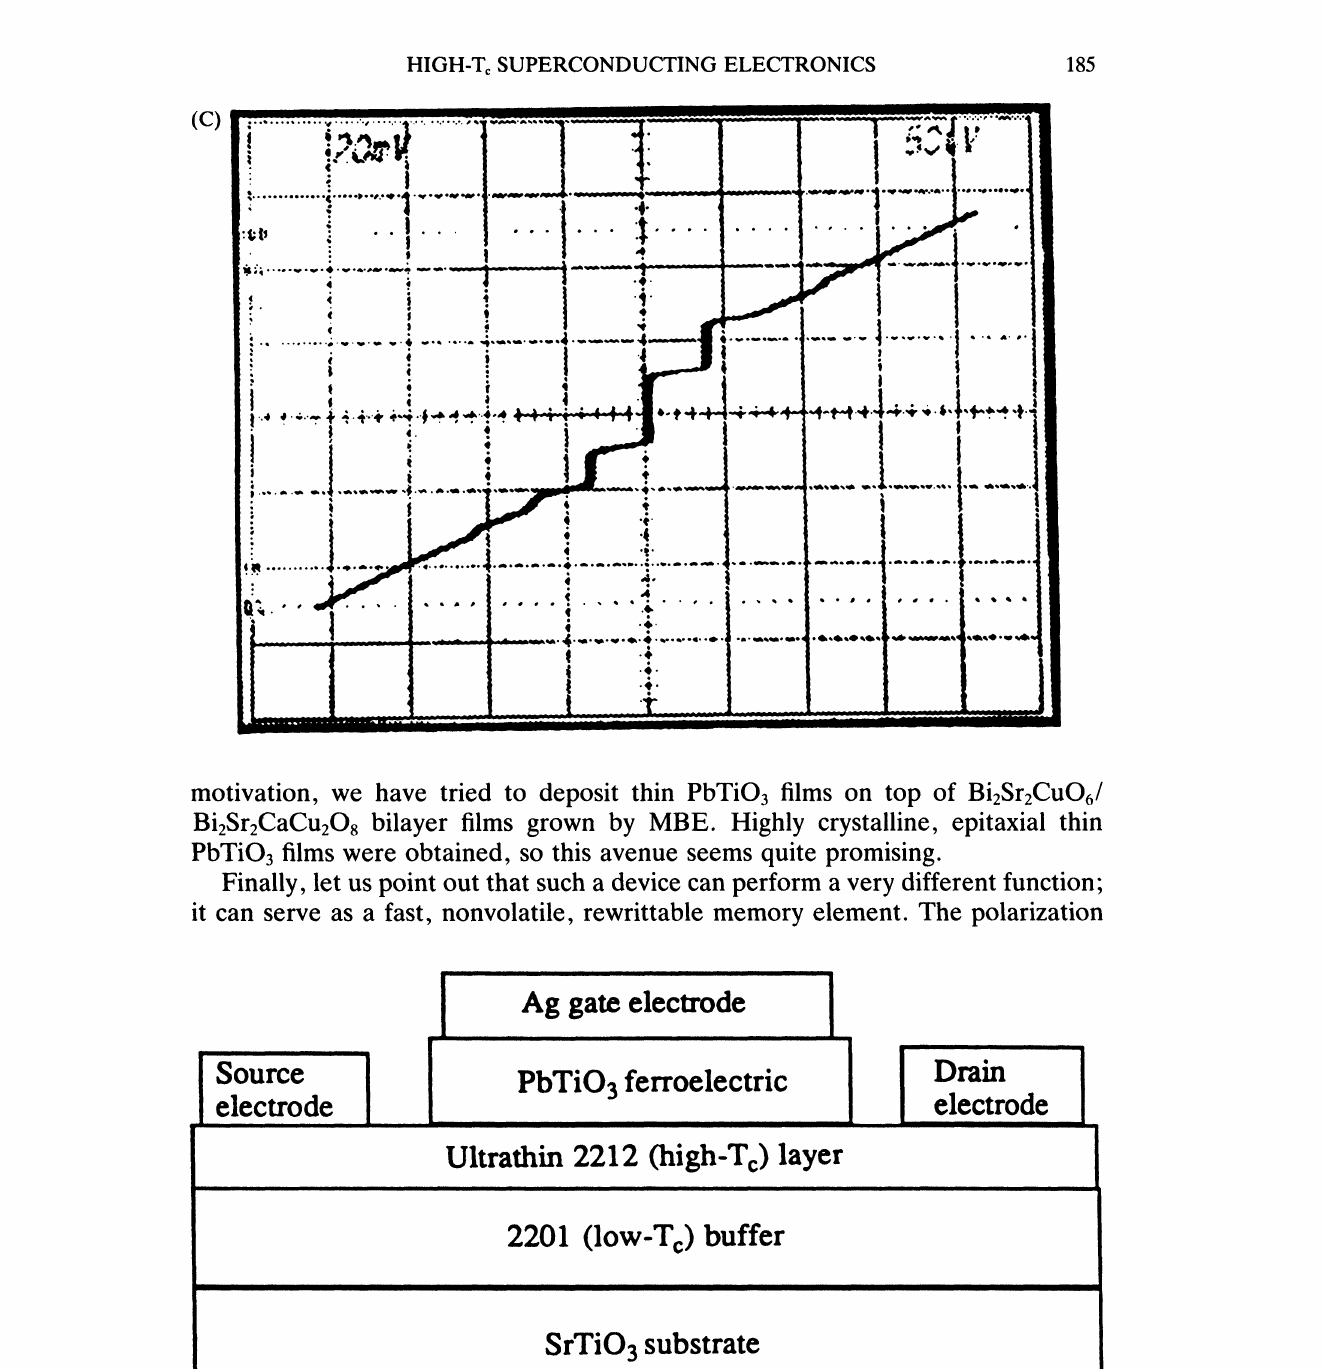
FIGURE 6 A schematic representation of a simple ferroelectric-superconductor field-effect device, FEST (not to